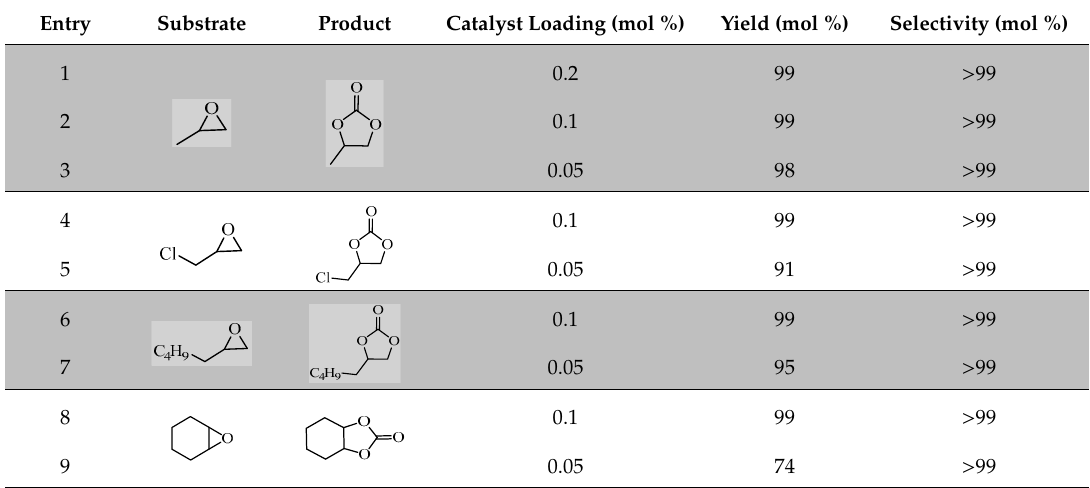
Table 4. Cycloaddition of CO 2 with various epoxides using PQPBr ‐ 2OH as a catalyst. a.